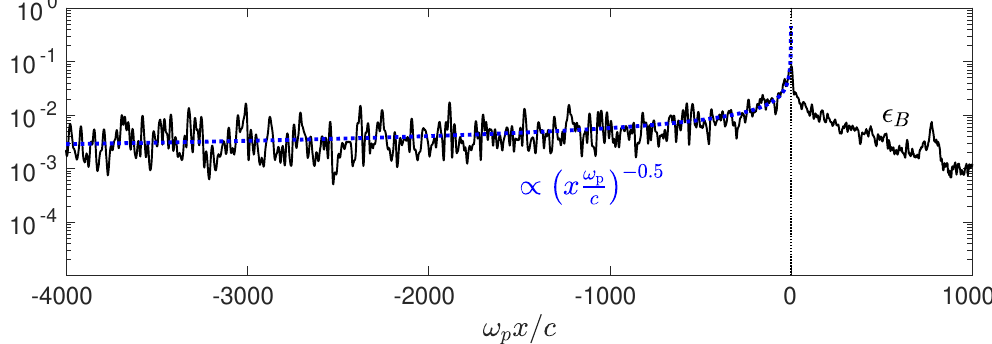
Figure 10. Decay of the microturbulence in the shocked region, as observed in a PIC simulation for γ sh = 17. The dashed blue line shows a law (cid:101) B ∝